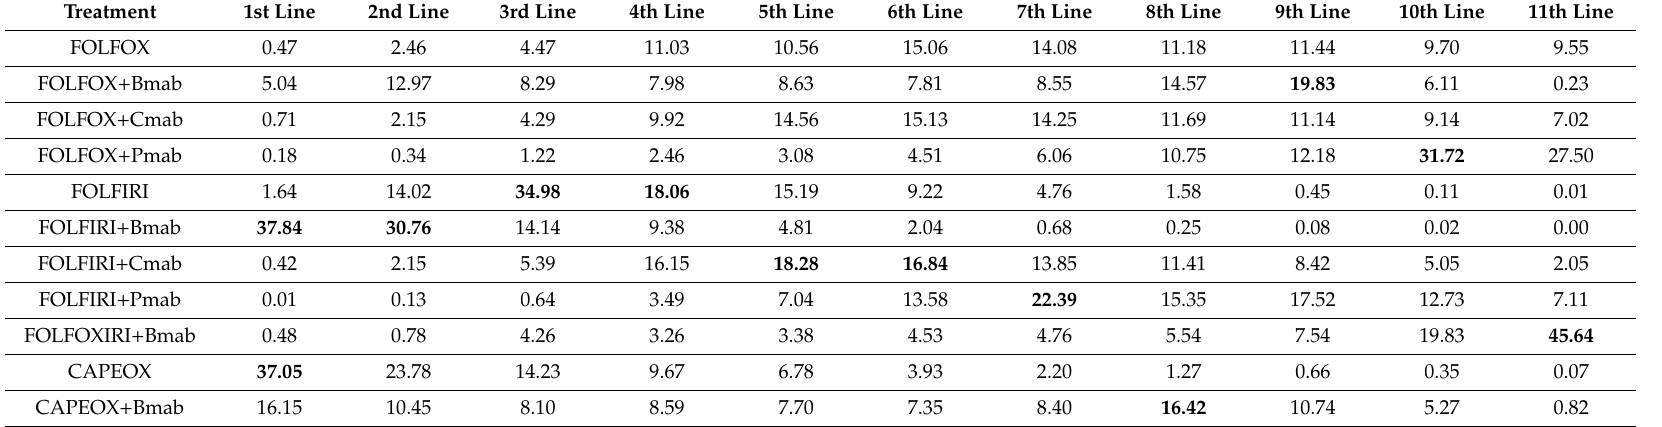
Table 6. Treatment ranking probability (%) for adverse events grade ≥